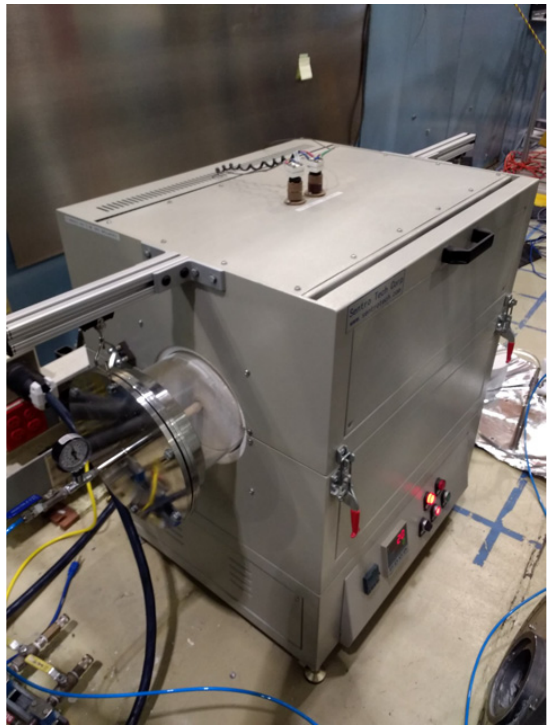
Figure 6. The large tube Furnace [14] used in the annealing work of Ref. [6].